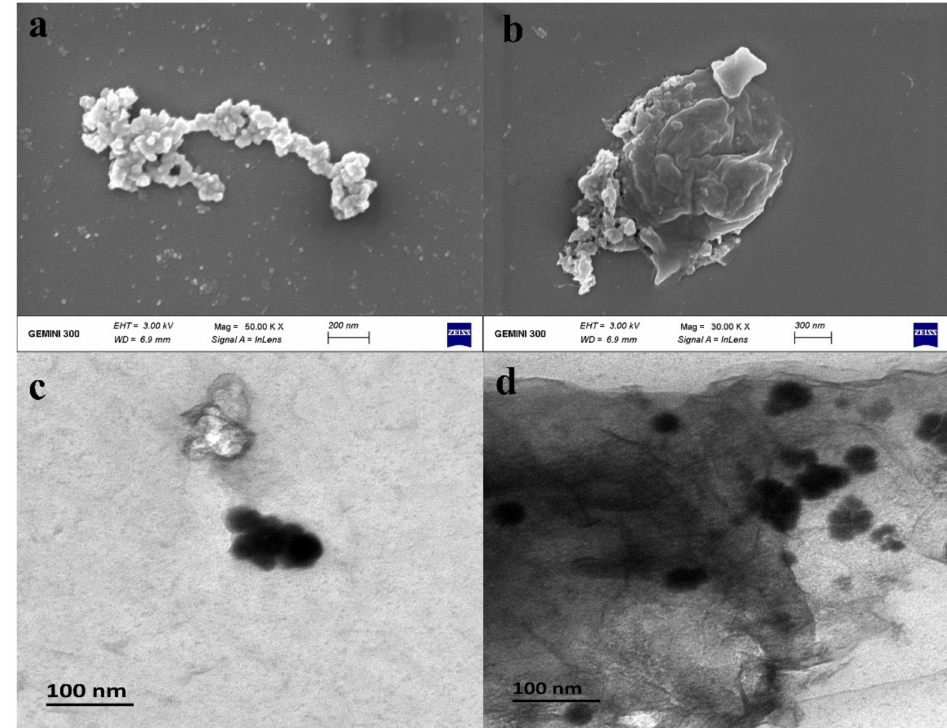
Figure 1. SEM and TEM images of nZVI ( a , c ) and B-nZVI ( b , d